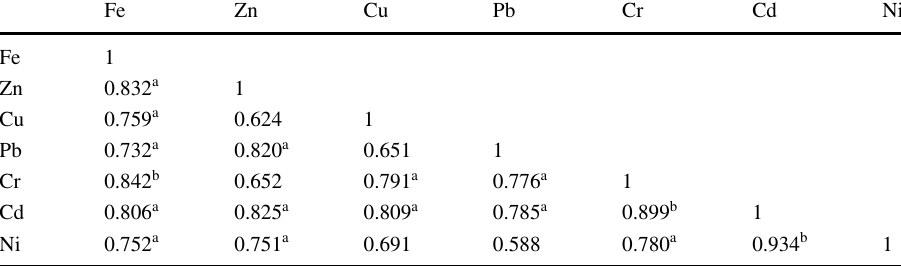
a Correlation is significant at the 0.05 level (two-tailed) b Correlation is significant at the 0.01